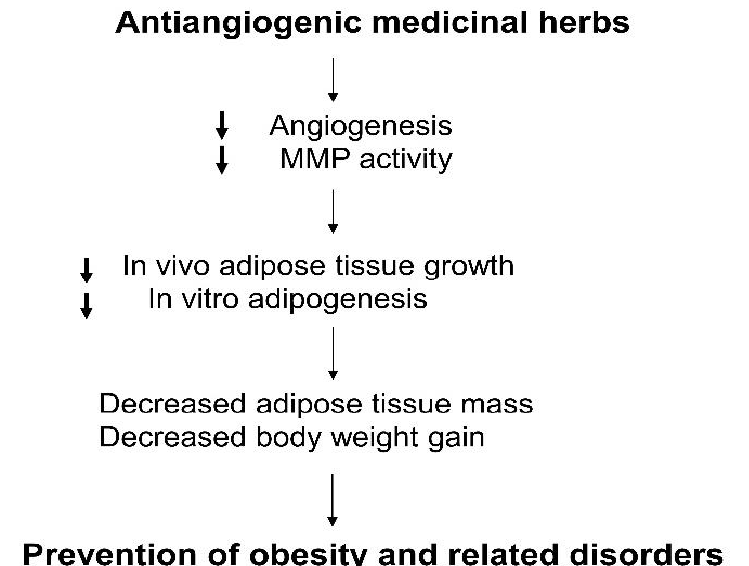
Figure 2. Regulation of obesity by antiangiogenic medicinal herbs.